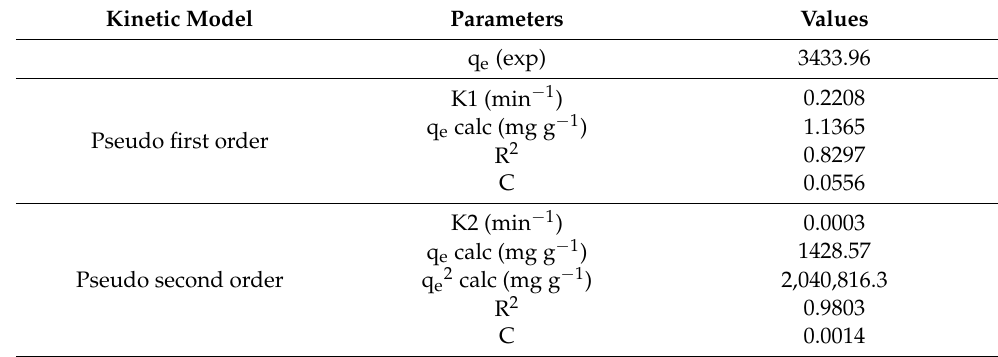
Table 5. Kinetic data for the adsorption of MY on CPSMNPs.